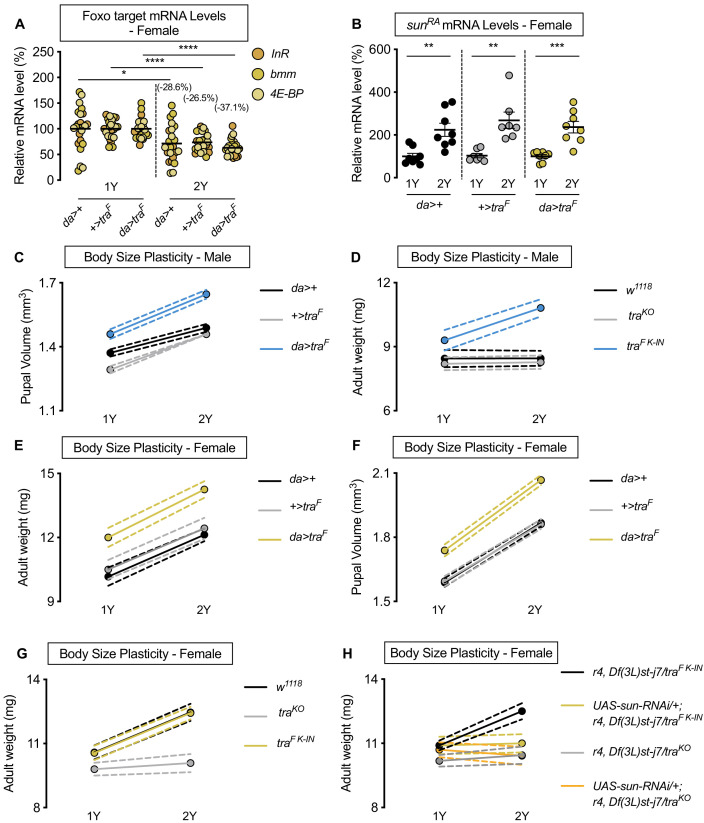
Sex determination gene transformer (tra) regulates increased nutrient-dependent body size plasticity.(A) In control da>+, +>UAS-traF and da>UAS-traF females, mRNA levels of Foxo targets (insulin receptor (InR), brummer (bmm), and eukaryotic initiation factor 4E-binding protein (4E-BP)), were significantly lower in larvae cultured on a protein-rich diet (2Y) compared with larvae raised on a diet containing half the protein content (1Y) (p=0.0124 [da>+], p<0.0001 [+>UAS-traF], and p<0.0001 [da>UAS-traF], respectively; Student’s t test). n = 8 biological replicates. (B) In control da>+ and +>UAS-traF, and da>UAS-traF females, mRNA levels of sunRA were significantly higher in larvae cultured on 2Y compared with larvae raised on 1Y (p=0.0024 [da>+], p=0.0013 [+>UAS-traF], and p=0.0003 [da>UAS-traF], respectively; Student’s t test). n = 8 biological replicates. (C) Pupal volume was significantly higher in da>+, +>UAS-traF, and da>UAS-traF males reared on 2Y compared with genotype-matched males cultured on 1Y (p<0.0001 for all genotypes; two-way ANOVA followed by Tukey HSD test). Importantly, the magnitude of the nutrient-dependent increase in pupal volume was higher in da>UAS-traF males (genotype:diet interaction p=0.0012; two-way ANOVA followed by Tukey HSD test). n = 70–91 pupae. (D) Adult weight was significantly higher in traF K-IN males, which express physiological levels of a functional Tra protein, when the males were reared on 2Y compared with genotype-matched males raised on 1Y (p<0.0001; two-way ANOVA followed by Tukey HSD test). In contrast, there was no significant increase in adult weight in w1118 and traKO male flies reared on 2Y compared with genotype-matched males raised on 1Y (p>0.9999 and p=0.9996, respectively; two-way ANOVA followed by Tukey HSD test). The magnitude of the nutrient-dependent increase in adult weight was significantly higher in traF K-IN males compared with w1118 and traKO male flies (genotype:diet interaction p<0.0001; two-way ANOVA followed by Tukey HSD test). n = 9–11 groups of 10 flies. (E) Adult weight was significantly higher in da>+, +>UAS-traF, and da>UAS-traF females reared on 2Y compared with genotype-matched females cultured on 1Y (p<0.0001 for all genotypes; two-way ANOVA followed by Tukey HSD test). The magnitude of the nutrient-dependent increase in adult weight was not significantly different between da>UAS-traF females and da>+ and +>UAS-traF controls (genotype:diet interaction p=0.5912; two-way ANOVA followed by Tukey HSD test). n = 6–8 groups of 10 flies. (F) Pupal volume was significantly higher in da>+, +>UAS-traF, and da>UAS-traF females reared on 2Y compared with genotype-matched females cultured on 1Y (p<0.0001 for all genotypes; two-way ANOVA followed by Tukey HSD test). n = 68–94 pupae. (G) Adult weight was significantly higher in both w1118 females, and in females with a knock-in transgene of the female isoform of tra (traF K-IN), when reared on 2Y compared with 1Y (p<0.0001 for both genotypes; two-way ANOVA followed by Tukey HSD test). In contrast, the nutrient-dependent increase in adult weight was abolished in tra mutant females (traKO) reared on 2Y compared with genotype-matched females cultured on 1Y (p=0.864; two-way ANOVA followed by Tukey HSD test). Importantly, the magnitude of the nutrient-dependent increase in adult weight was significantly lower in traKO females, which lack a functional Tra protein, than in w1118 and traF K-IN females (genotype:diet interaction p<0.0001; two-way ANOVA followed by Tukey HSD test). n = 10–16 groups of 10 flies. (H) Adult weight was significantly higher in r4-GAL4 control females with traF K-IN, when reared on 2Y compared with 1Y ((p<0.0001 [r4,Df(3L)st-j7/traF K-IN]); two-way ANOVA followed by Tukey HSD test). In contrast, the nutrient-dependent increase in adult weight was abolished upon fat body knockdown of sun in a traF K-IN female ((p=0.9999 [UAS-sun-RNAi/+;r4,Df(3L)st-j7/traF K-IN]); two-way ANOVA followed by Tukey HSD test). Adult weight was not different in tra mutant r4-GAL4 females (r4,Df(3L)st-j7/traKO) reared on 2Y compared with genotype-matched females cultured on 1Y (p=0.9550; two-way ANOVA followed by Tukey HSD test). Importantly, adult weight was not further reduced in 1Y with fat body knockdown of sun in a tra mutant female ((UAS-sun-RNAi/+;r4,Df(3L)st-j7/traKO) (p=0.99 [UAS-sun-RNAi/+;r4,Df(3L)st-j7/traF K-IN v UAS-sun-RNAi/+;r4,Df(3L)st-j7/traKO]); two-way ANOVA followed by Tukey HSD test). n = 9–12 groups of 10 flies. For body size plasticity graphs, filled circles indicate mean body size, and dashed lines indicate 95% confidence interval. * indicates p<0.05, ** indicates p<0.01, *** indicates p<0.001, **** indicates p<0.0001; error bars indicate SEM.